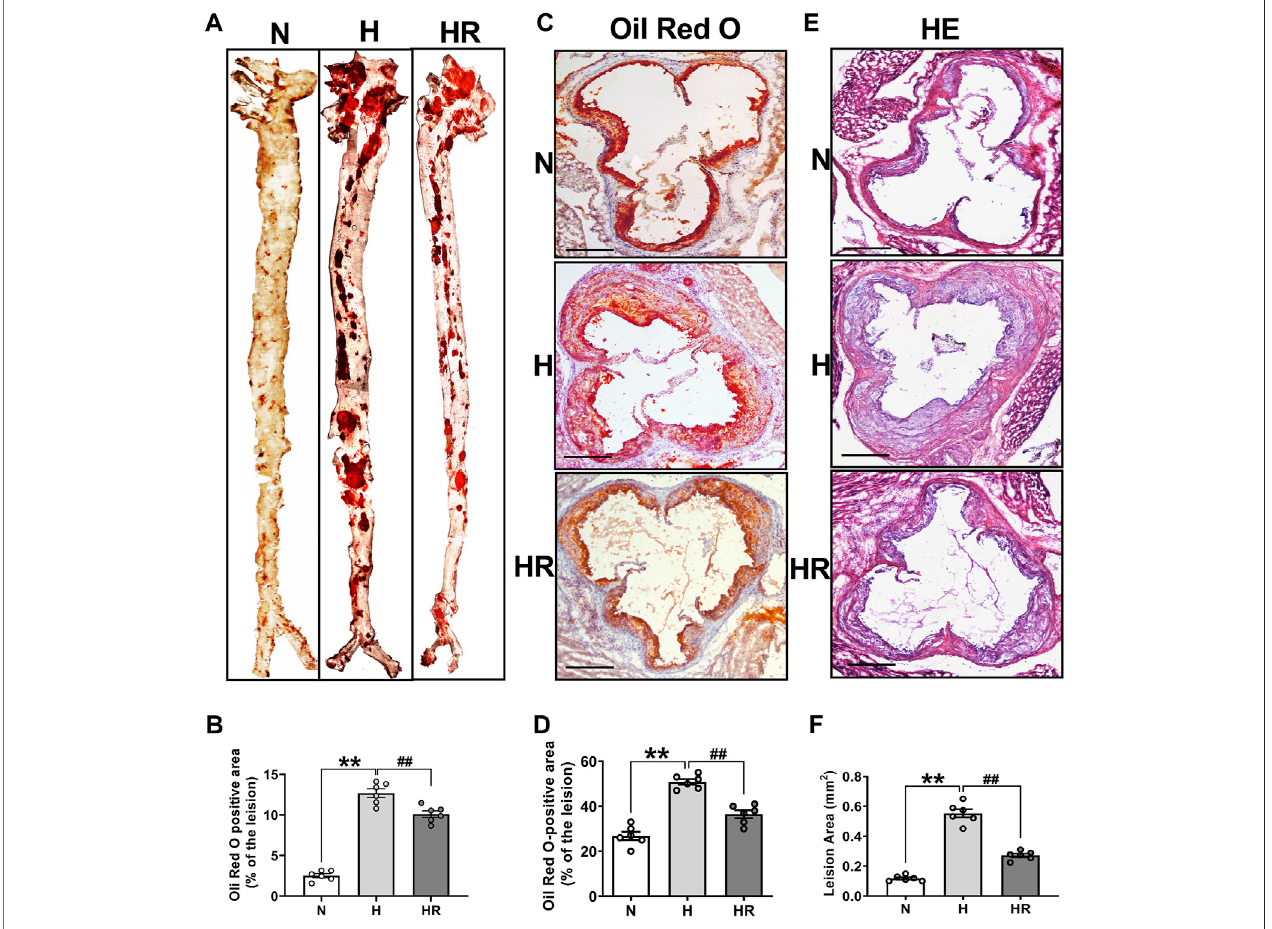
FIGURE 1 | Resveratrol alleviated high-fat diet (HFD) – induced atherosclerosis in ApoE − / − mice. (A) Representative images of en face aortas. (C,E) Oil Red O stainingandHEstainingofaorticrootsections.Scalebar:100 μ m. (B,D,F) Quanti fi cationoflipidcontentandlesionsize. n (cid:2) 6miceineachgroup.Alldataarethemean